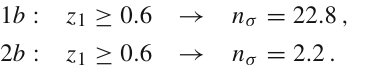
s -channel single (anti-)top cross sections, which domi- nate the 2 b samples; (ii) the uncertainty in the t -channel single top cross section is fully correlated in the 1 b and 2 b samples, and the combination of both measurements would have smaller systematics. Alternatively, one can use the measurement in one of the final states to predict the t j cross section in the other